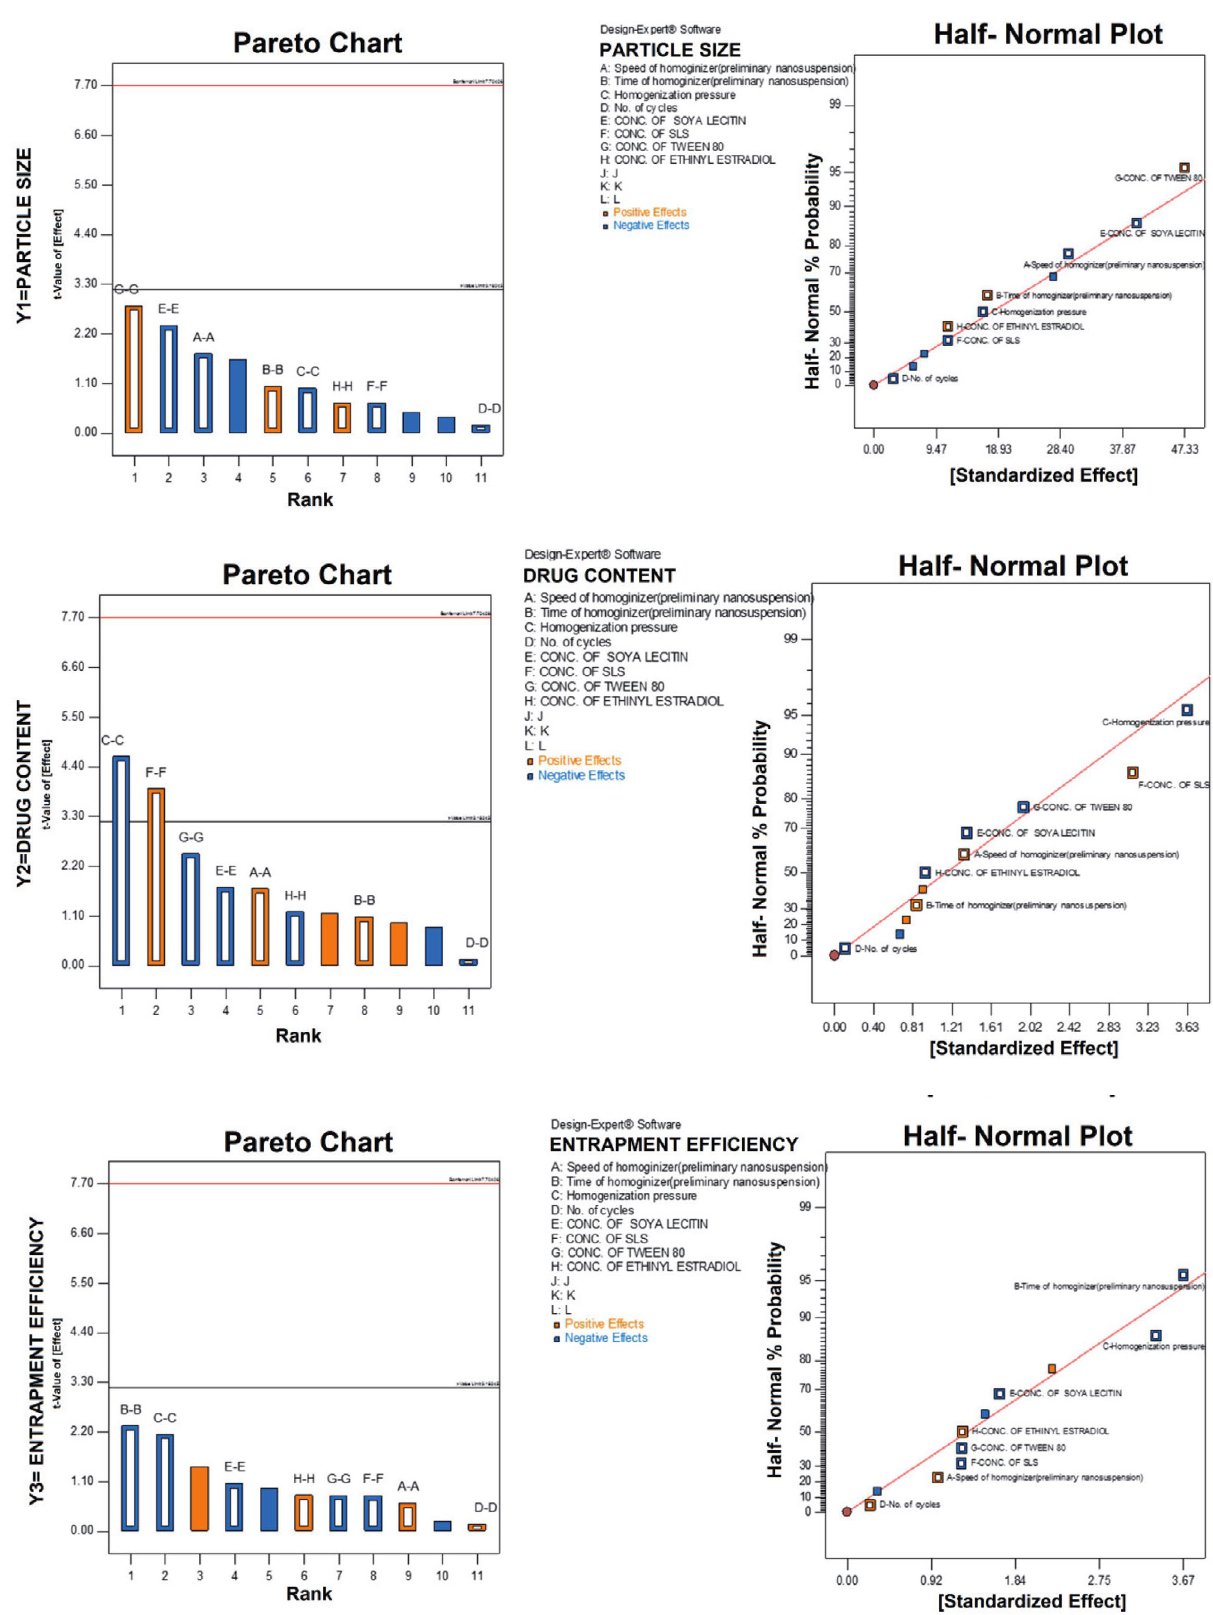
Figure 3. The half-normal plot and Pareto charts showing the significant process and formulation variables on particle size, drug content and entrap- ment